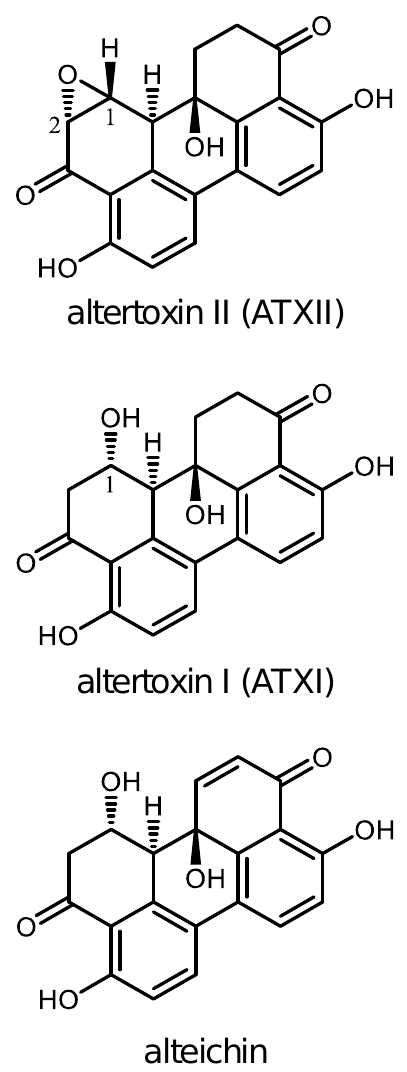
Figure 1. Chemical structures of ATXII and its analogues ATXI and alteichin purified from Alternaria sp. SC5920 TV8-1.